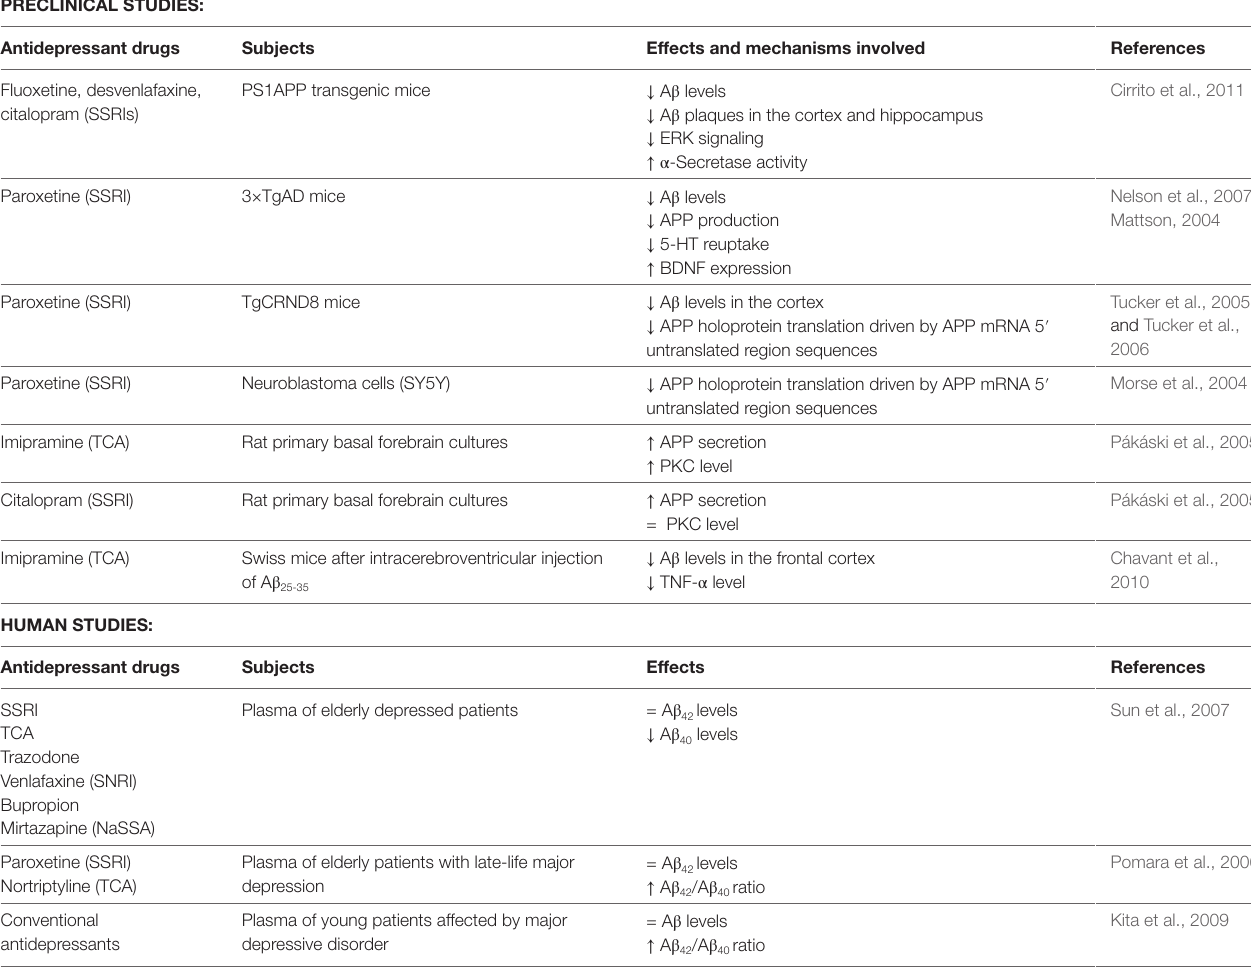
TABLE 1 | Effect of antidepressant drugs on A β